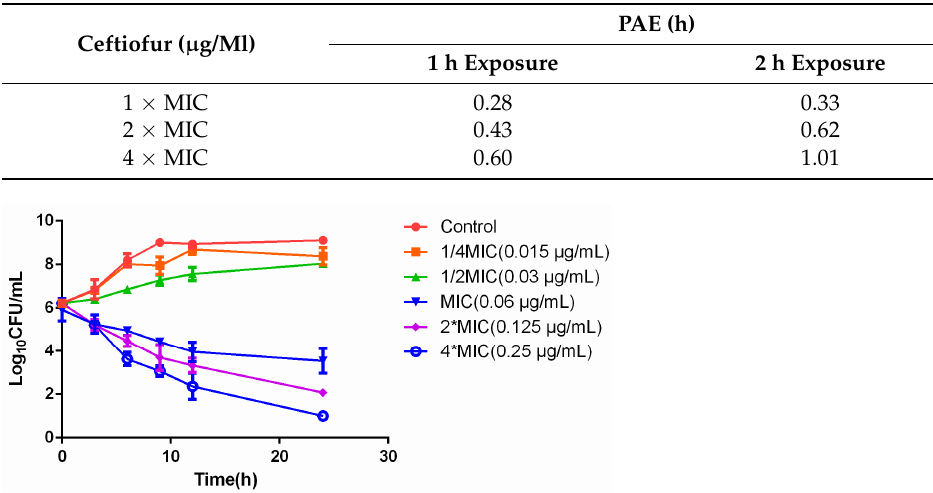
Table 1. Post antibiotic effect (PAE) of CEF against P. multocida after 1 h and 2 h.